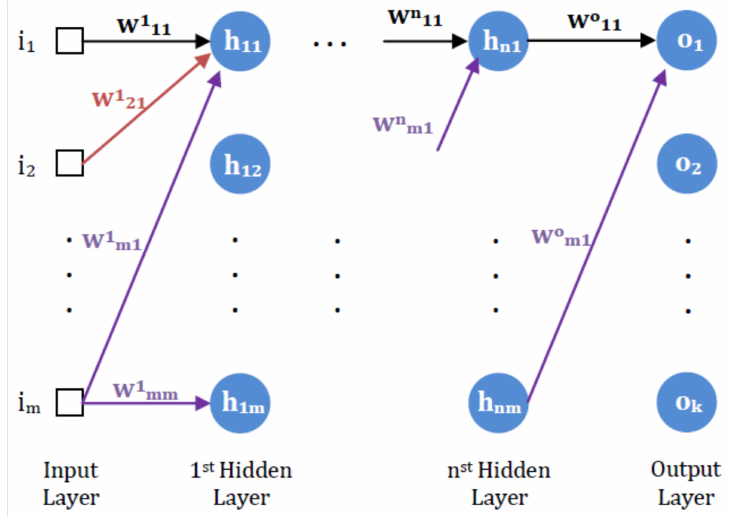
Figure 8. General structure MLNN with weights’